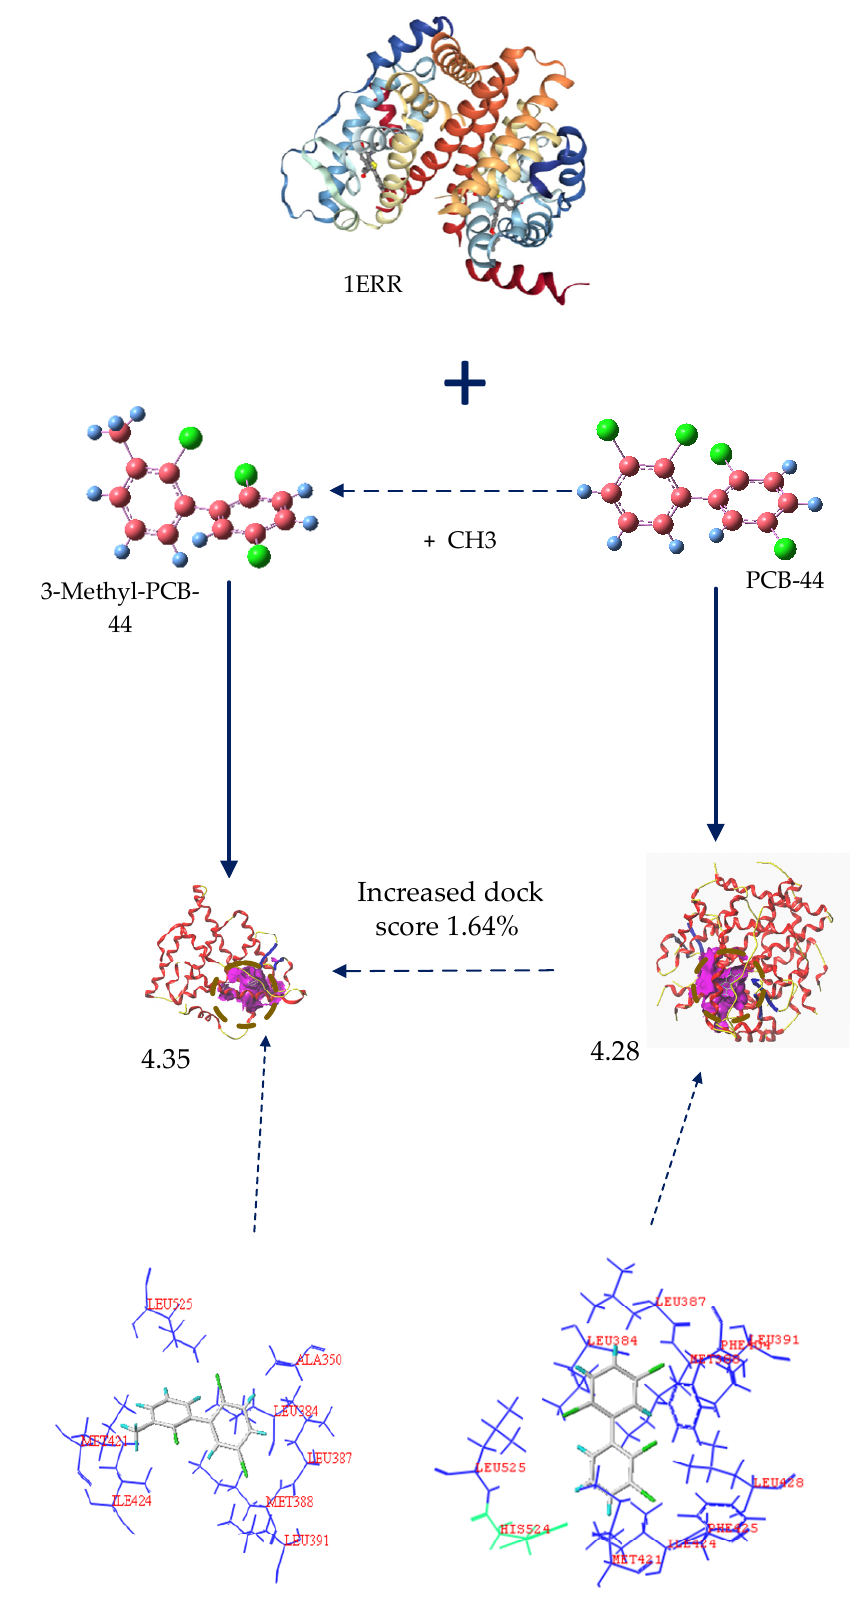
Figure 4. Binding conformation of 3-methyl-PCB-44 to 1ERR receptor protein.